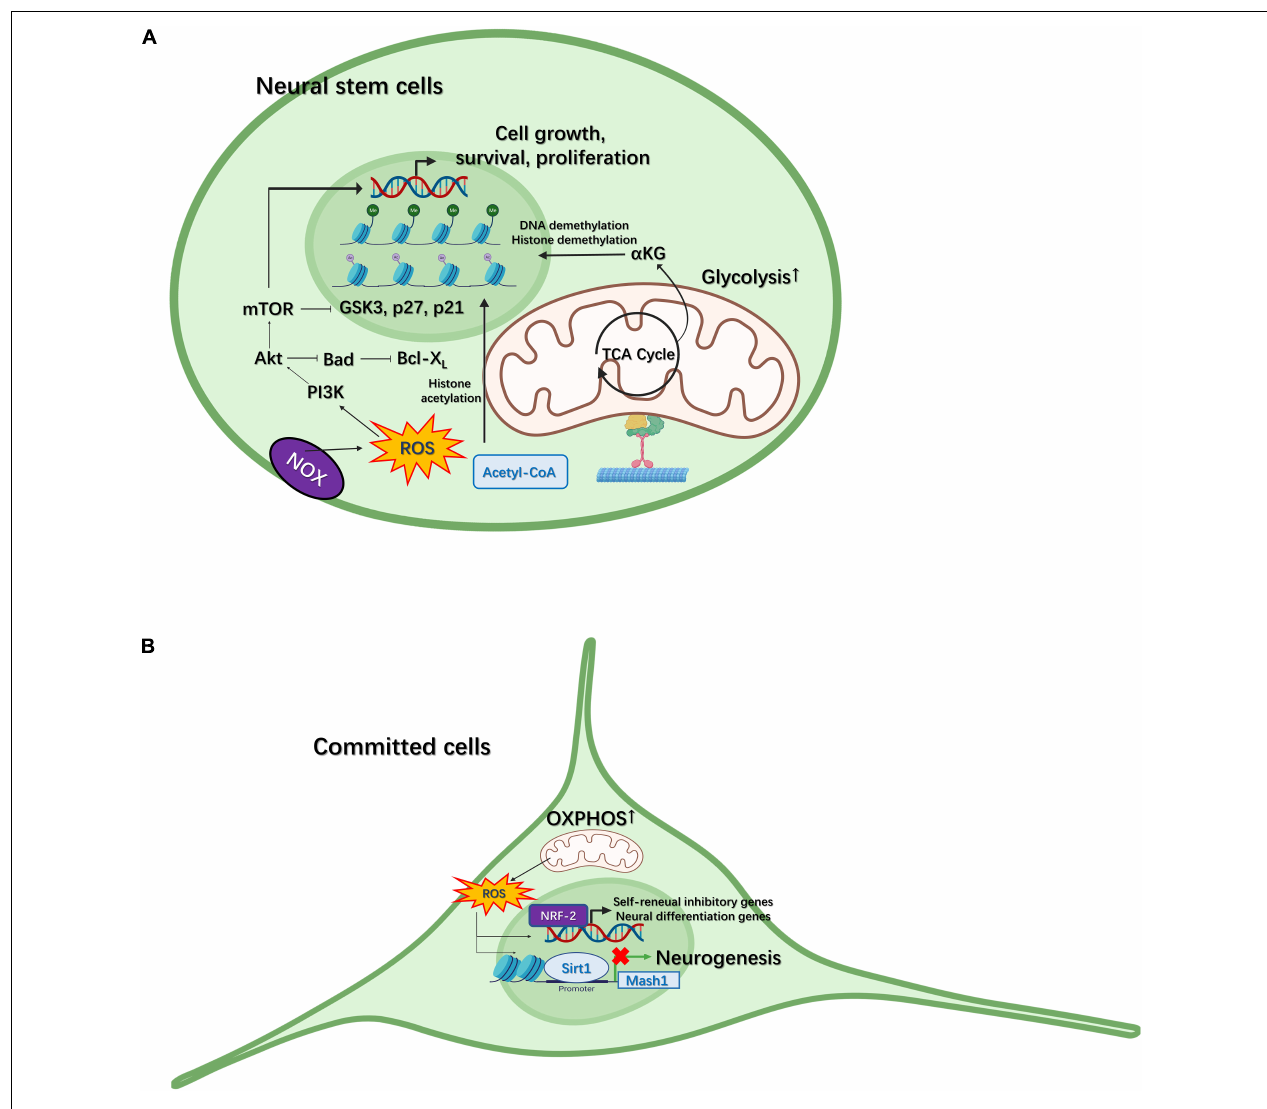
FIGURE 2 | Mitochondria participate in neural differentiation in neural stem cells (NSCs) and committed cells. (A) Intermediate metabolites generated in the tricarboxylic acid (TCA) cycle, such as α –ketoglutarate ( α KG), can regulate neurogenesis through histone/DNA demethylation for the maintenance of stem cell pluripotency. Reactive oxygen species (ROS) generated through NADPH-oxidase (NOX) can regulate the proliferation of NSCs via the PI3K/AKT pathway. (B) In committed cells, the metabolic pattern gradually switches from glycolysis to oxidative phosphorylation (OXPHOS). ROS generated through the electron transport chain (ETC) can activate self-renewal-inhibiting and neural differentiation-promoting genes via NRF2-dependent retrograde signaling. In contrast, ROS can also facilitate the SIRT1-mediated inhibition of Mash1 expression, thereby guiding NPCs to an astroglial fate.